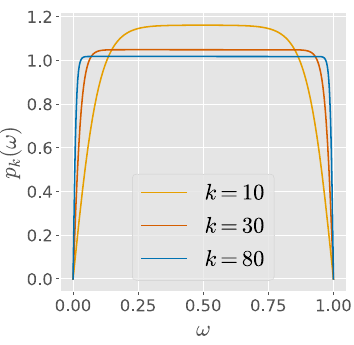
FIG. 5. Analytic approximations of a flat prior that vanishes at the endpoints of its domain. The plotted functions correspond to Eq. (C5) with a = 0 and b = 1 for different values of k